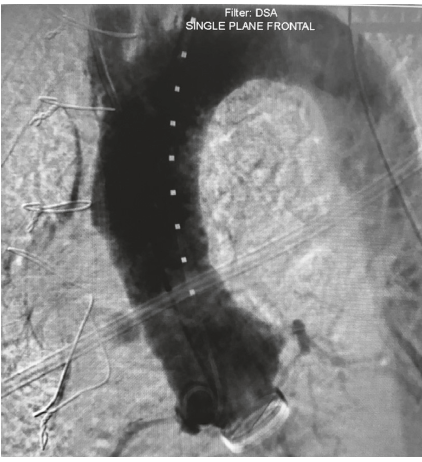
Figure 2: Aortic root angiogram with marker pigtail to verify sizing.